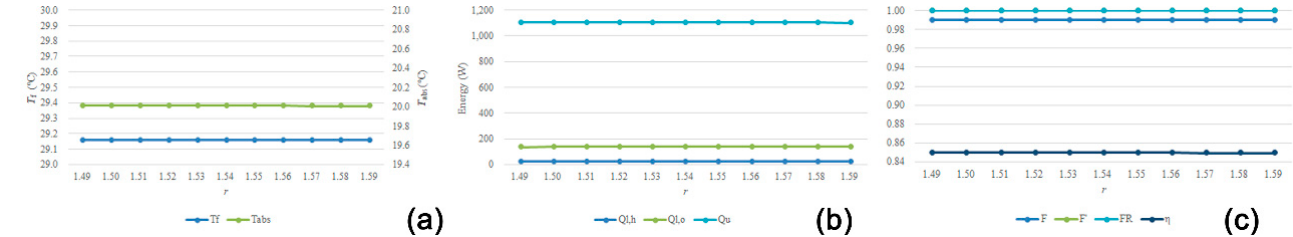
Figure 18. Influence of transparent cover refractive index ( r ) . ( a ) Dependence between T f , T abs , and r . ( b ) Dependence between energy, and r . ( c ) Dependence between efficiency parameters, and r .